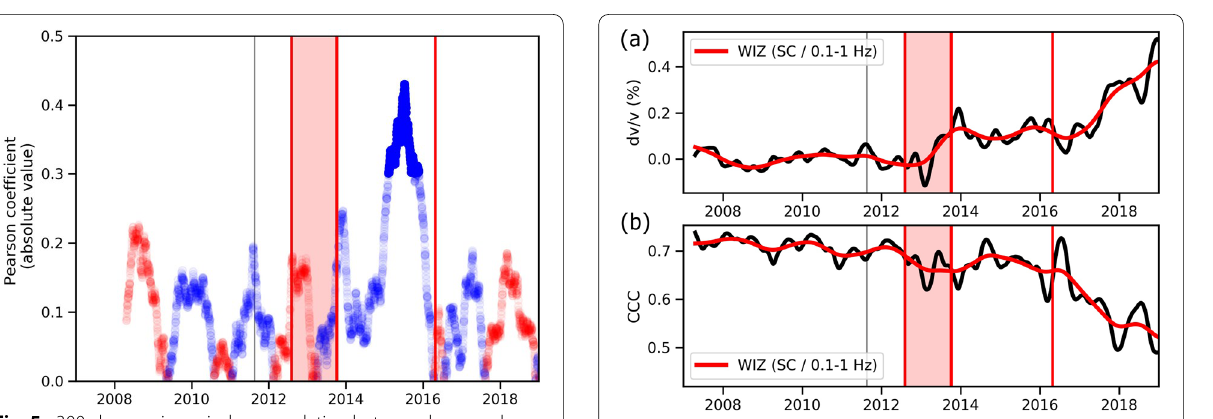
Fig. 6 a Seismic velocity variations (single station cross-component approach). b Cross Correlation Coefficient (CCC) between the reference function (entire time period) and the current function (0.1–1.0 Hz). The black and red lines correspond to the daily mean values across different combinations of components (EN, EZ and ZN) smoothed using a Hodrick–Prescott filter with different values, 500,000 and 100,000,000, respectively. See Fig. 4 for the description of the vertical lines corresponding to key time